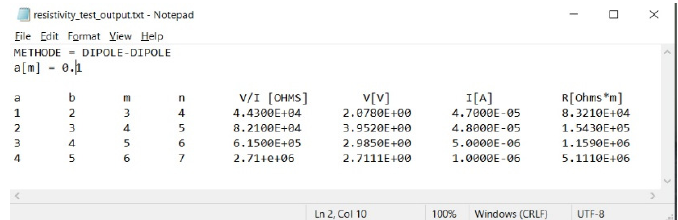
Figure 4. Post-processing data structure from electrical test.